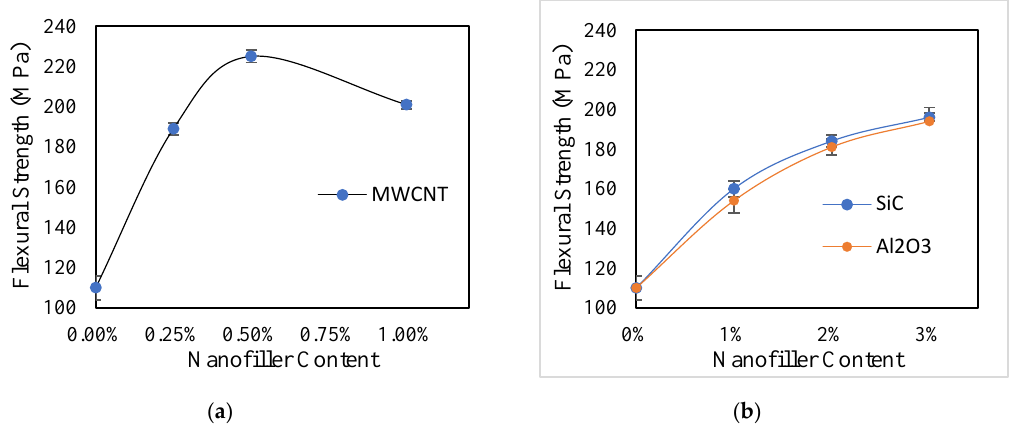
Figure 8. Flexural strength of nanofiller reinforced composite samples: ( a ) MWCNT, ( b ) SiC, and Al 2 O 3.